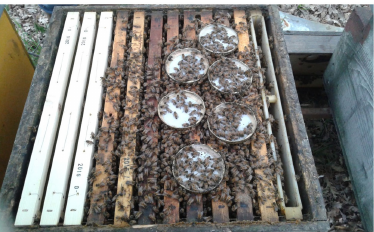
Figure 1. The new technique to administer OTC sucrose solution to the colonies using jar caps on the top of the